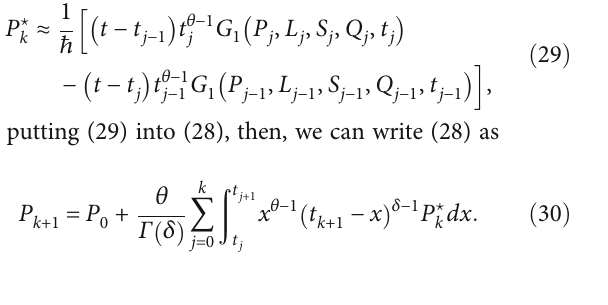
Figure 2: Graphical representation of light smokers ( L ð t Þ ) having two di ff erent initial values of L (1) at di ff erent arbitrary fractal dimension and fractional